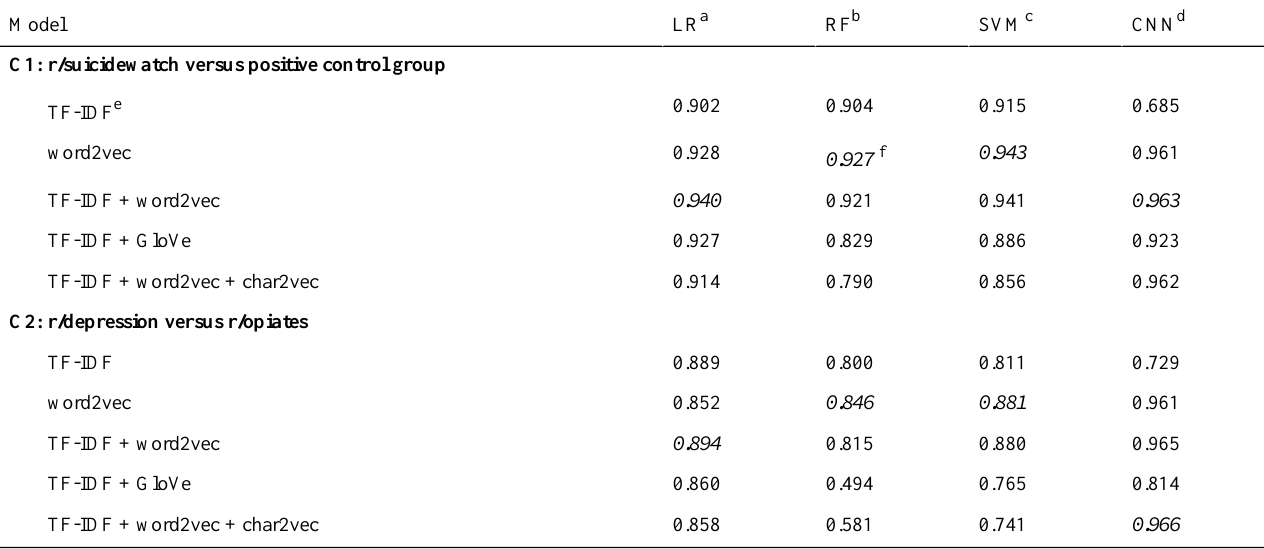
Table 3. F 1 scores achieved for the given different combinations of input for classification.